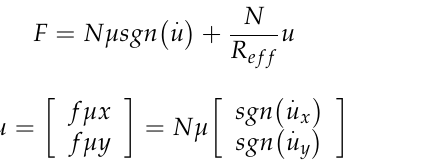
Figure 10. ( a ) Intrinsic force-deformation response of a conventional CSFS. ( b ) Decomposed fric- tion force of a conventional CSFS. ( c ) Decomposed restoring force of a conventional curved surface friction slider.